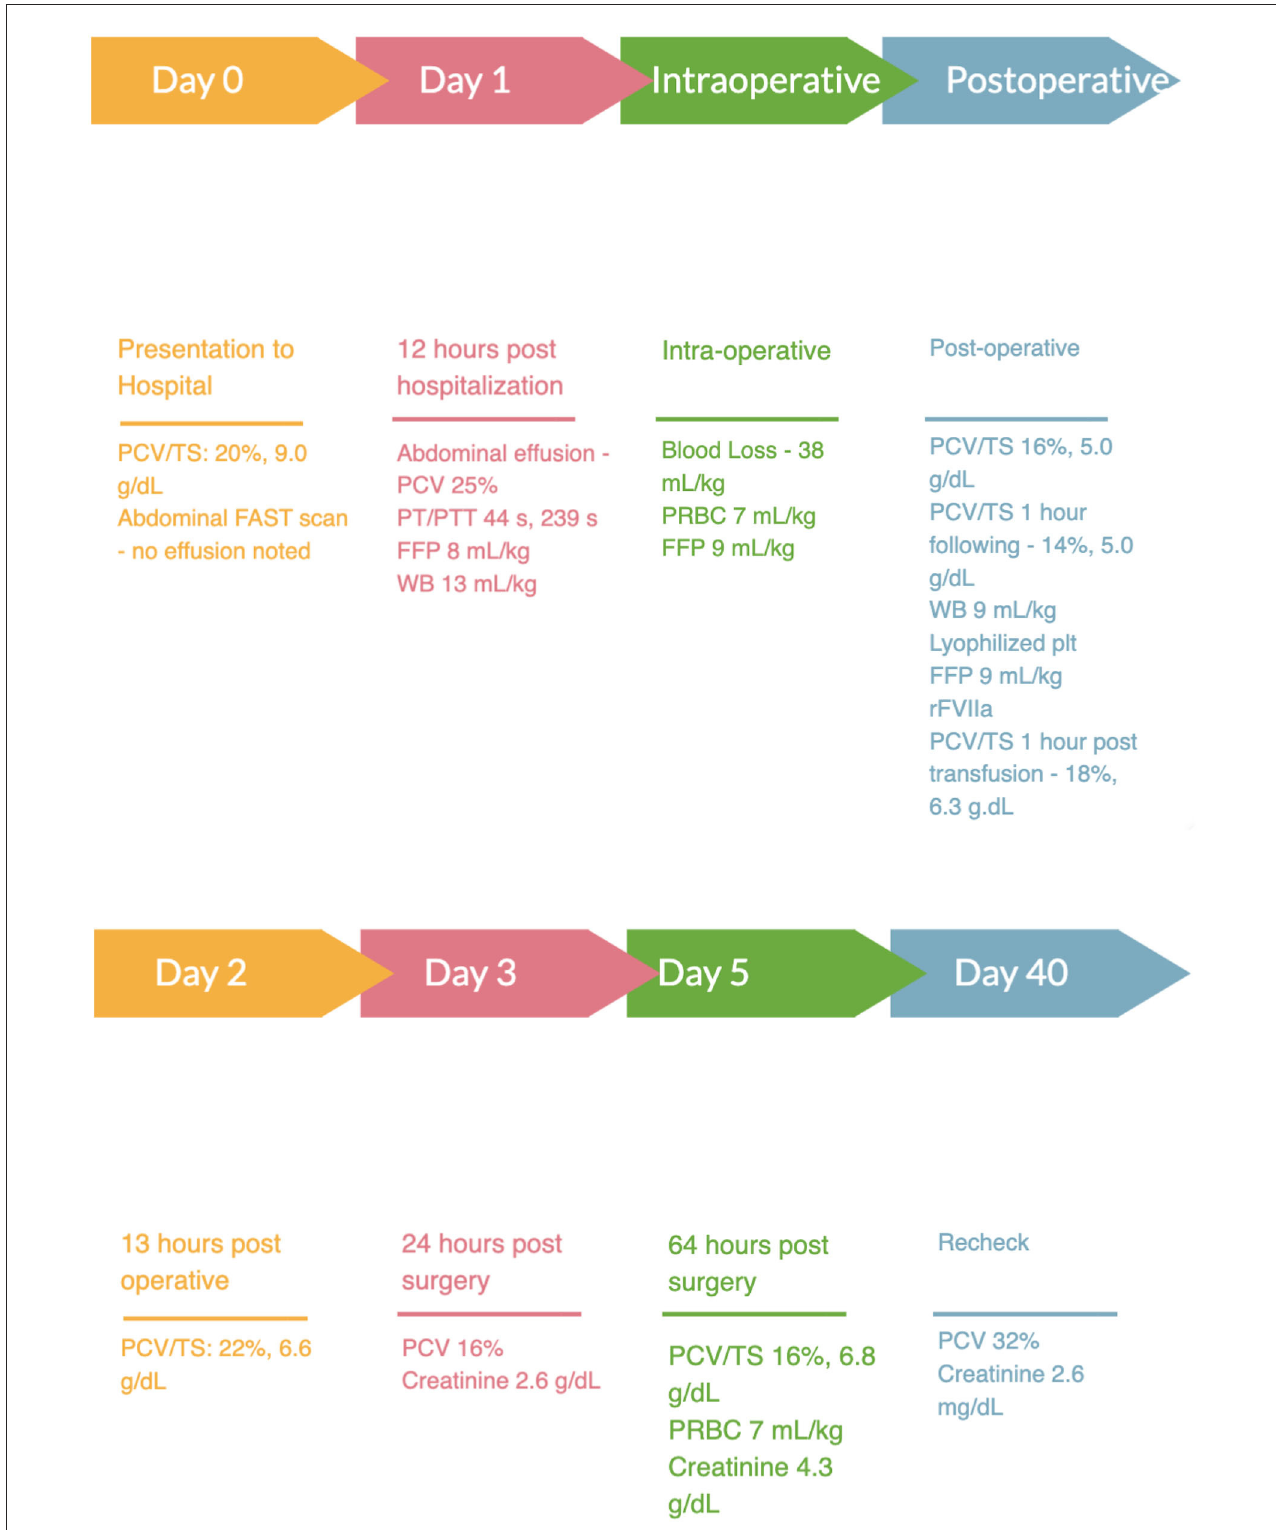
FIGURE1 Timeline of hospitalization. PCV, packed cell volume; TS, total solids; FFP, fresh frozen plasma; WB, whole blood; PRBC, packed red blood cells; rFVIIa, recombinant factor